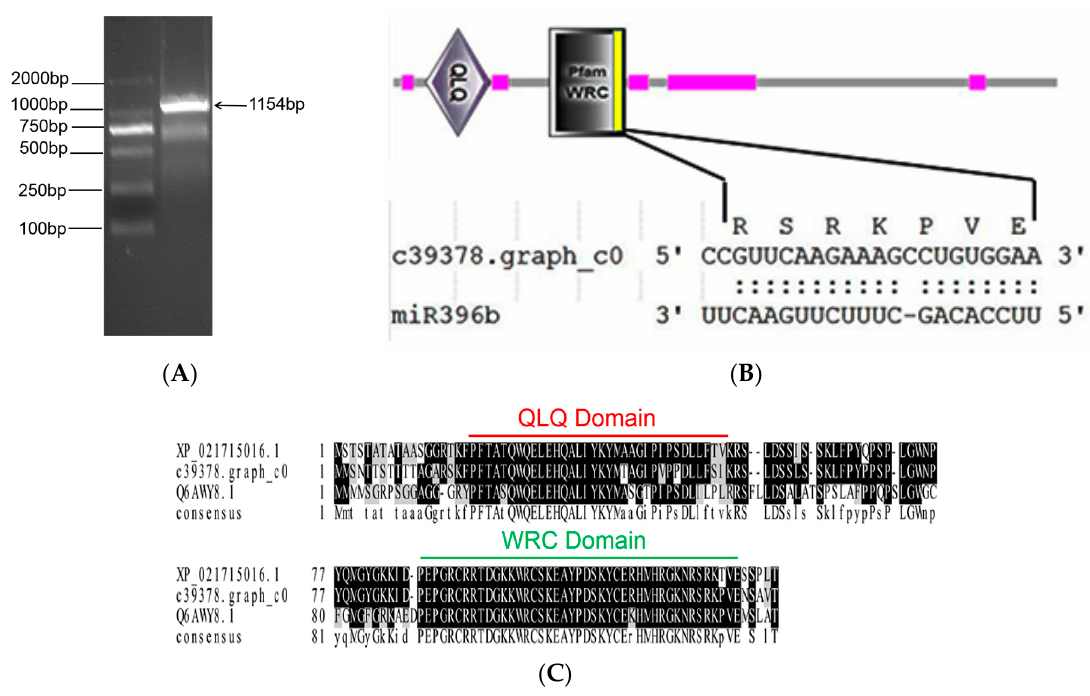
Figure 6. Cloning and sequence analysis of HpGRF6 : ( A ) electrophoresis of cloned HpGRF6 ; ( B ) prediction of the conservative domain of HpGRF6 , whose conserved domains are QLQ and WRC, and the double black points indicate matched base pairs; ( C ) amino acid sequence alignment of HpGRF6 with the conserved domains of other plant species. XP_021715016.1, Q6AWY8.1 and c39378.graph_c0 represent the plants C. quinoa , A. thaliana , and H. polyrhizus , respectively. Residues that are identical are highlighted in black and different residues are highlighted in grey background.